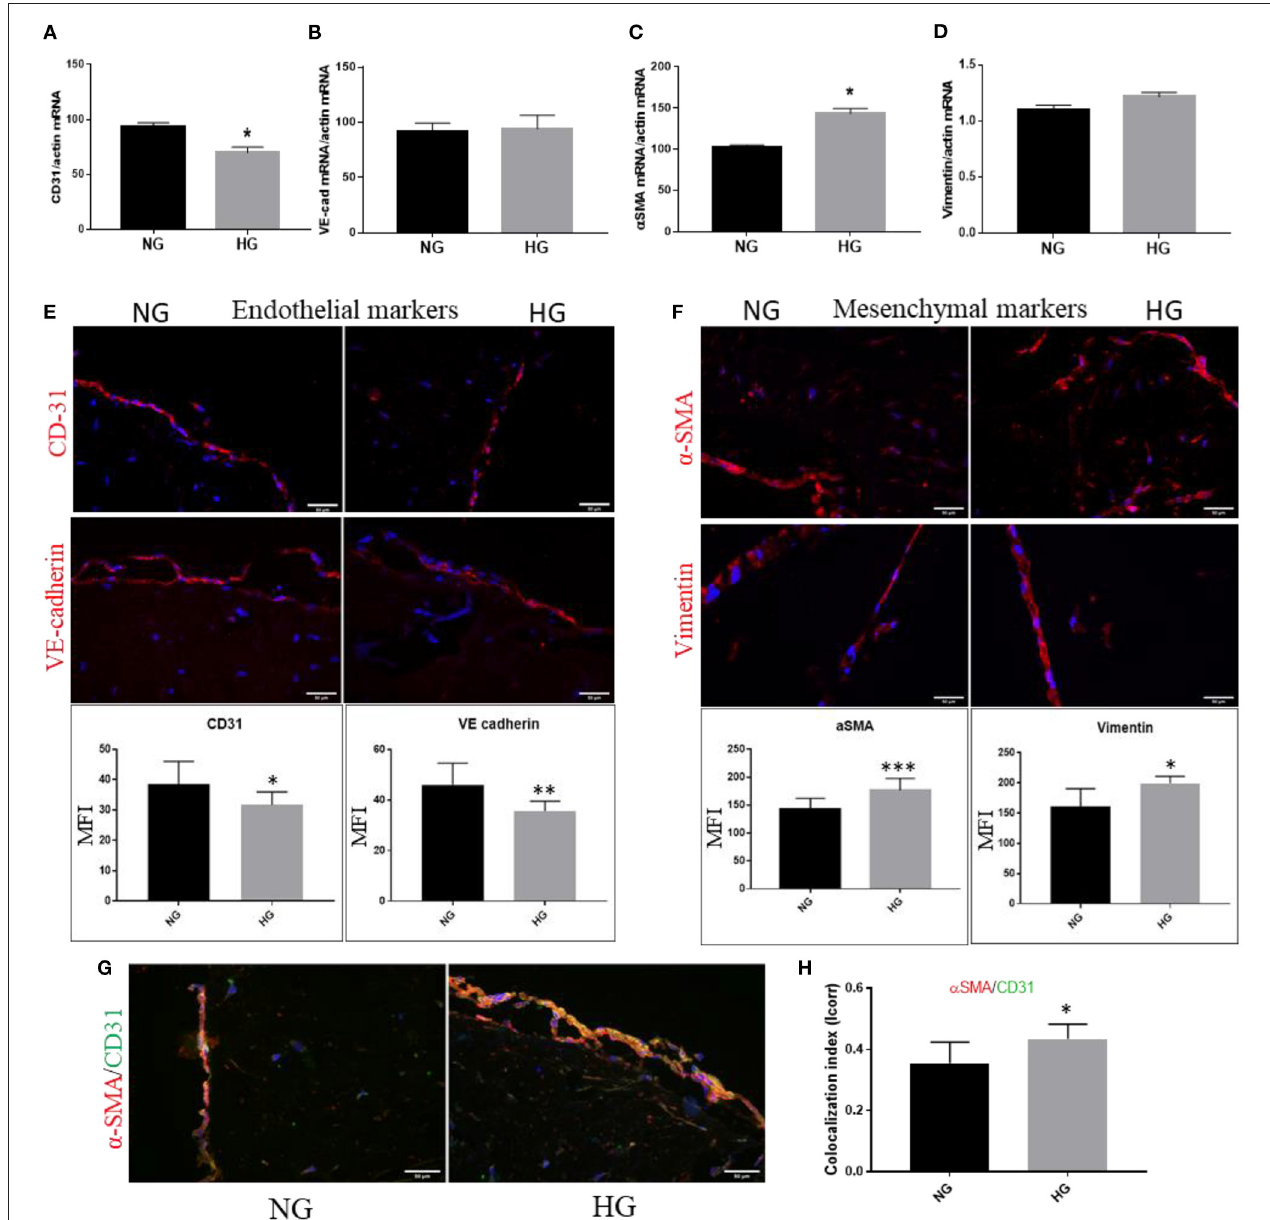
FIGURE 5 | High glucose induces endothelial–mesenchymal transition in VEC from 3D construct. mRNA expression of endothelial markers CD-31 and VE-cadherin (A,B) and mesenchymal markers α -SMA and vimentin (C,D) VEC isolated from 3D-constructs cultured for 7days in NG or HG conditions. n = 3, * p < 0.05, ** p < 0.01, *** p < 0.001. (E,F) . Immunofluorescence staining of endothelial markers – CD31 and VE-cadherin (E) , of mesenchymal markers – α SMA and vimentin (F) and co-localization of endothelial CD31 (green) with mesenchymal marker α SMA (red) in valvular cells after 7 days of normal (control) and high glucose exposure (G)